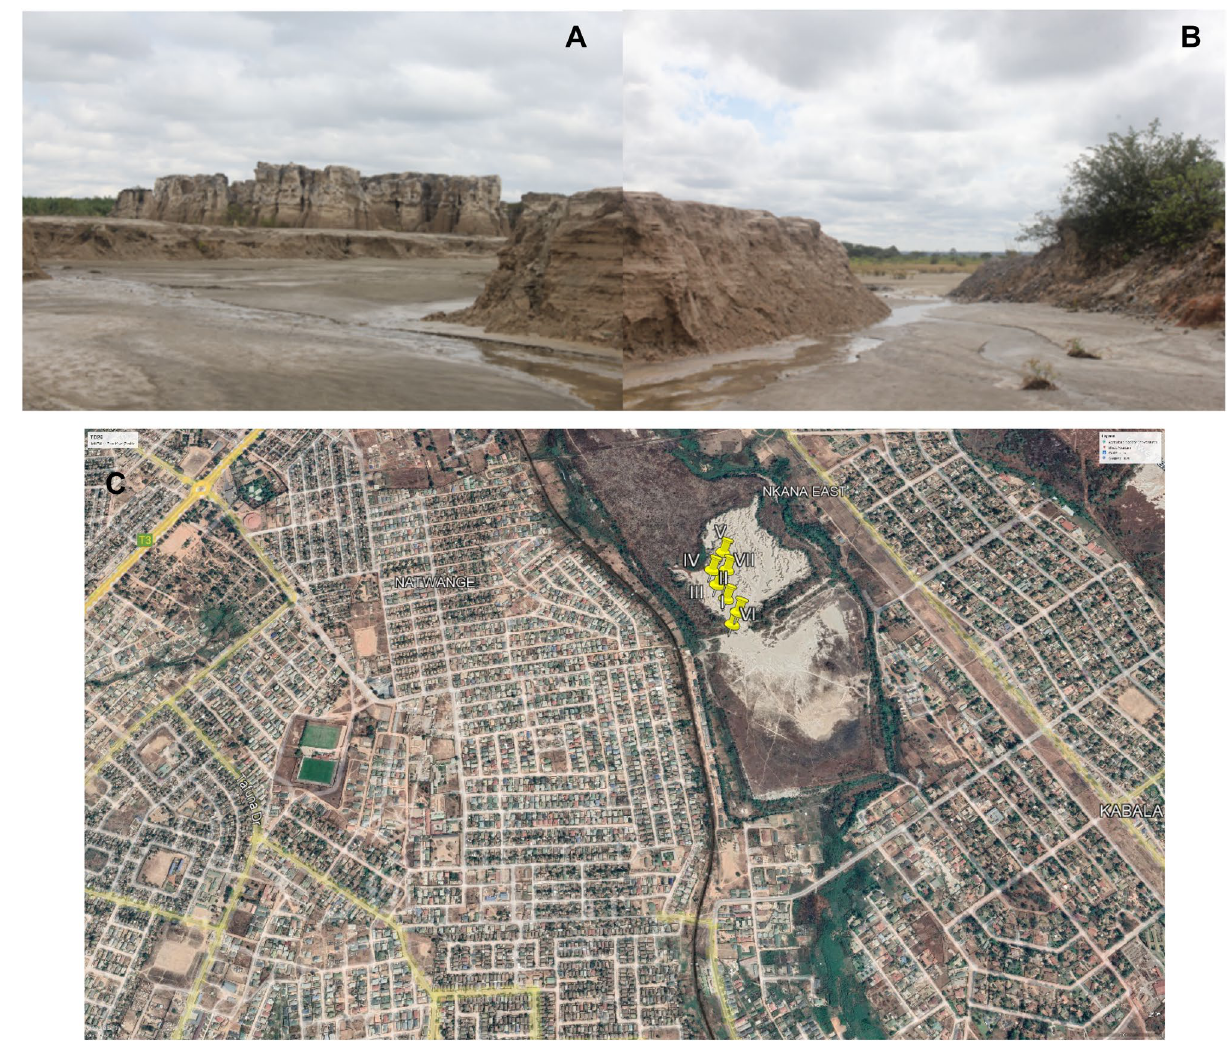
Figure 3. Uchi Tailing Dam (TD26). ( A , B ) Photographs showing compacted slurry on tailings, and gullies formed by water during the rainy seasons. The images: Leonce, June 2021. ( C ) An aerial photograph showing sampling points in yellow numbered I to VII at Uchi tailing dam location (TD26) and surrounding area, Google Earth Satellite Image system, January